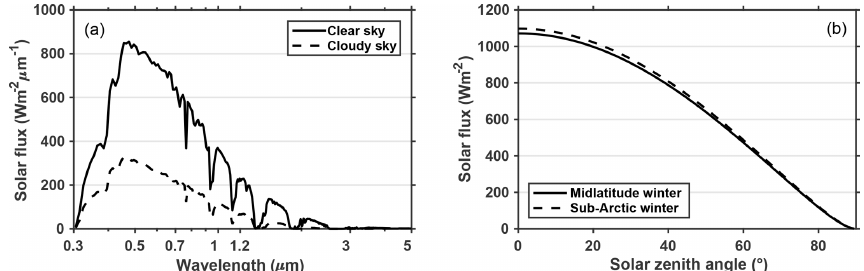
Figure 1. Spectral and total down-welling solar flux at surface computed using SWNB2 for (a) standard clear-sky and cloudy-sky atmospheric profiles of midlatitude winter assuming solar zenith angle is 60 ◦ at the top of the atmosphere, and for (b) standard clear-sky profiles of midlatitude and sub-Arctic winter with different incident solar zenith angles.